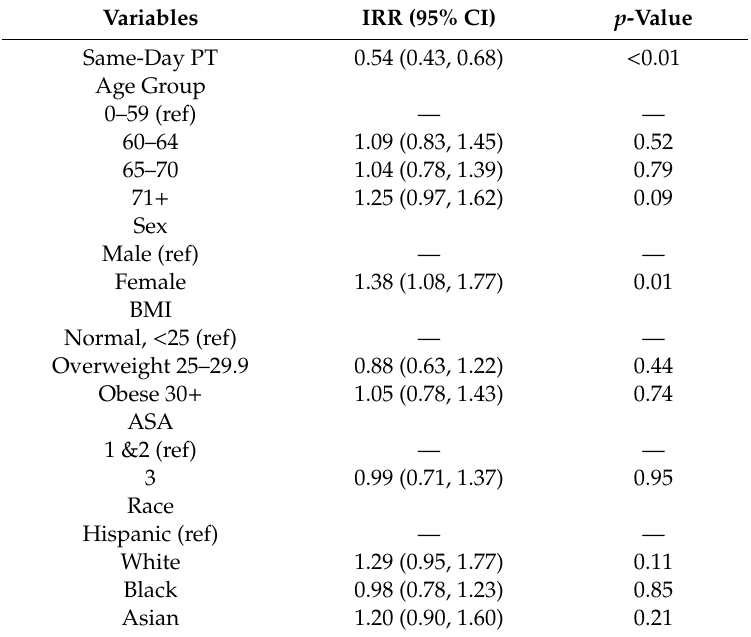
Table 3. Multivariable Poisson regression for length of stay predicted by same-day physical therapy and patient characteristics.